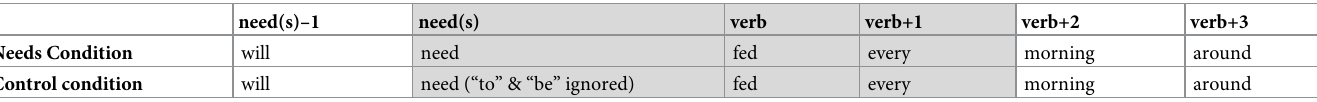
Table 1. Critical regions (in gray) for analysis and figs, for Experiments 1 and